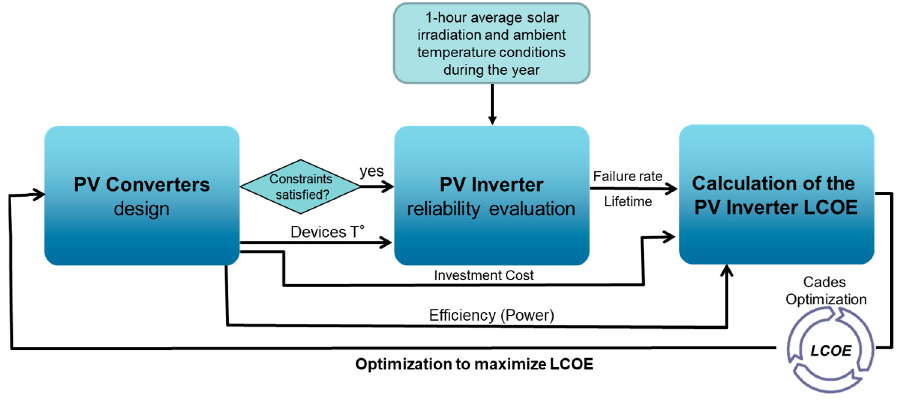
Figure 19. The flowchart of LCOE optimization.